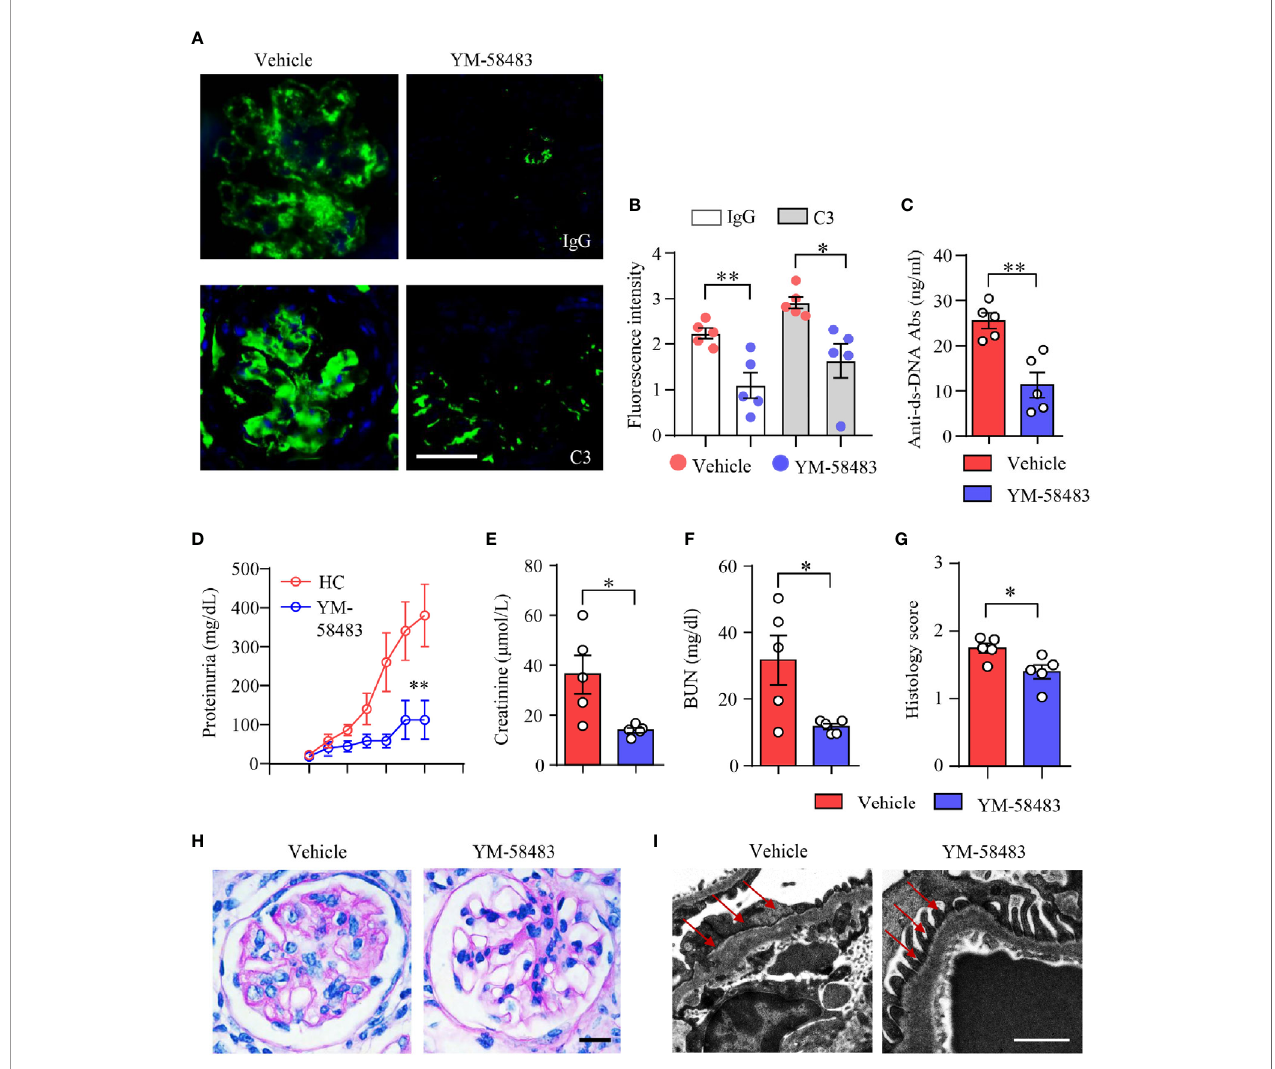
FIGURE 7 | YM-58483 reduced immune deposition and ameliorated kidney damage in NZM2328 lupus mice. NZM2328 mice were treated with YM-58483 (1 mg/kg) or vehicle intraperitoneal once a day for 6 weeks. (A, B) OCT-embedded kidney samples from YM-58483- or vehicle-treated mice were sectioned and stained with antibodies against IgG and C3. Sections were counterstained with DAPI and visualized using a fl uorescence microscopy. Representative images are shown. Fluorescence intensity of IgG or C3 were summarized and shown as dot plot with bar plot. Scale bar 50 m M. (C) Anti-dsDNA antibodies (anti-dsDNA) in the sera of YM-58483- or vehicle-treated mice was measured by ELISA and shown as dot plot with bar. (D) Proteinuria of YM-58483- or vehicle-treated mice were monitored and recorded weekly. (E, F) Concentrations of creatinine or blood urea nitrogen (BUN) in the sera. (G, H) Kidney samples from YM-58483- or vehicle-treated mice were stained with PAS. Histology score for PAS staining was summarized. Representative images were shown. Scale bar 20 m M. (I) Kidney samples were prepared for transmission electron microscopy to assess the pathological features of glomeruli. Electron microscope images. Red arrows indicate foot process of podocytes. Scale bar 0.5 m M. n = 5 in the vehicle group and n = 5 in the YM-58483 group. All data are mean ± SEM. *p < 0.05, **p < 0.01 by